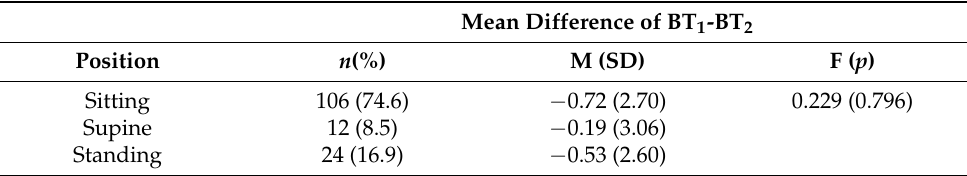
Table 2. Differences in mean difference of BT 1 -BT 2 by position.